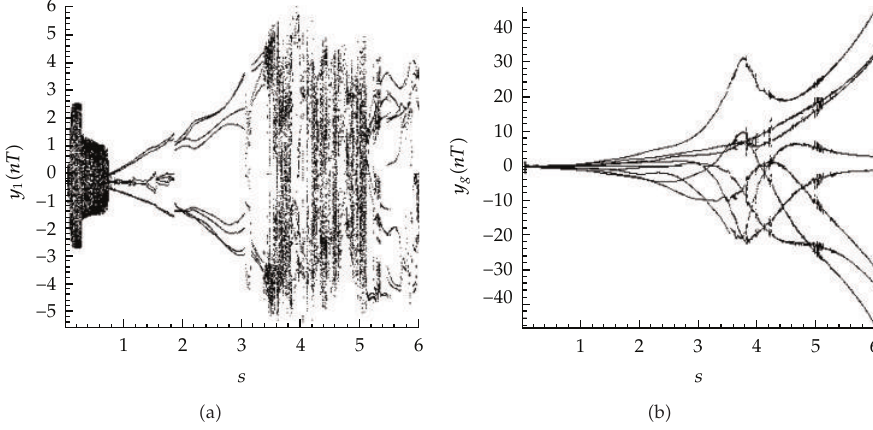
Figure 5: Bifurcation diagrams of gear-bearing system using dimensionless rotational speed ratio, s , as bifurcation parameter for non-Newtonian lubricating fluid with l ∗ (cid:9) 0 .